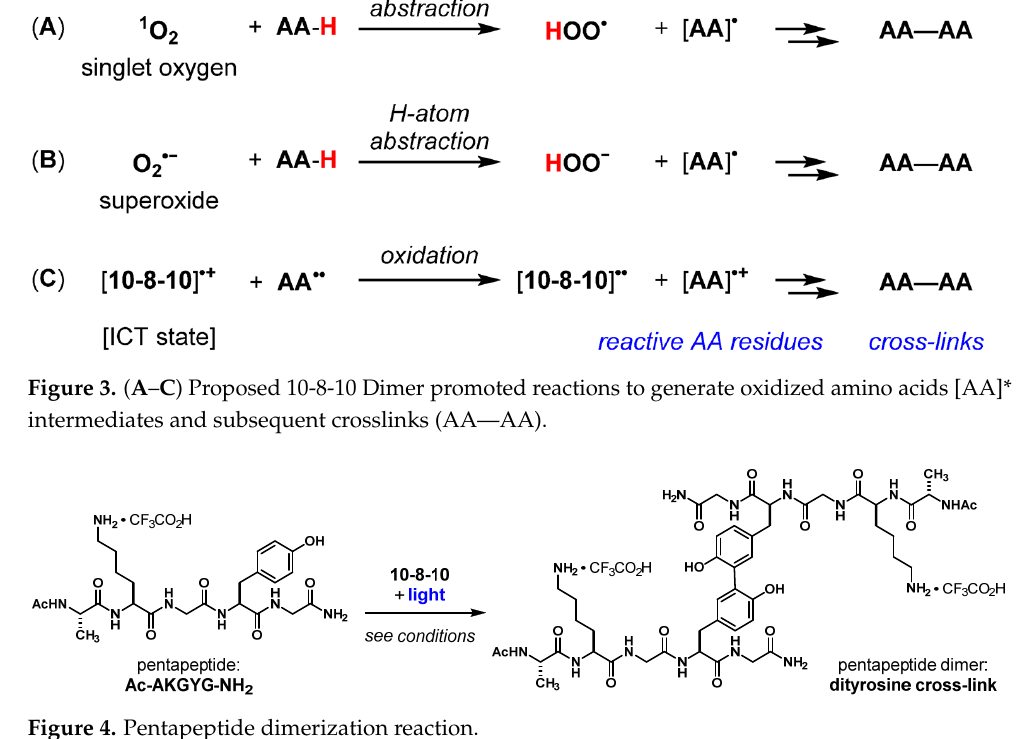
Figure 4. Pentapeptide dimerization reaction.